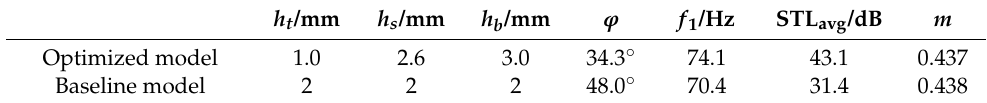
Table 5. Results after optimization in the high-frequency range.